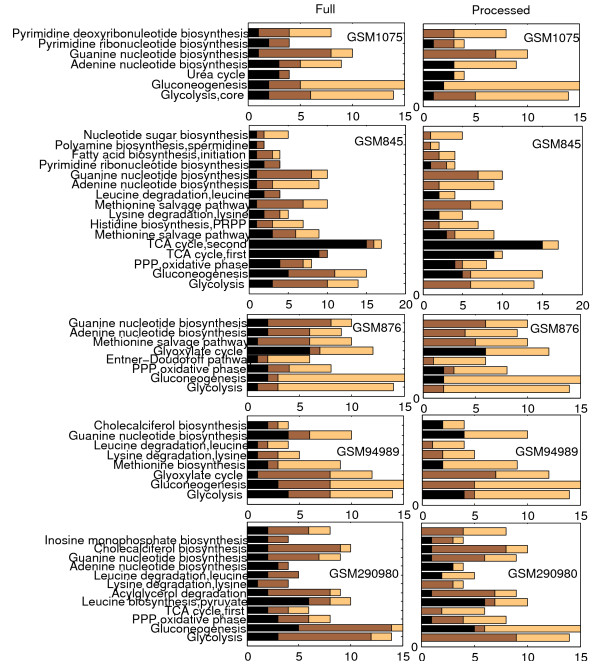
Full membership allocation and processed allocations. The figure reveals the number of up-, down-regulated and stable genes in each of the sample pathways, before and after processing of the data, for a number of experiments.